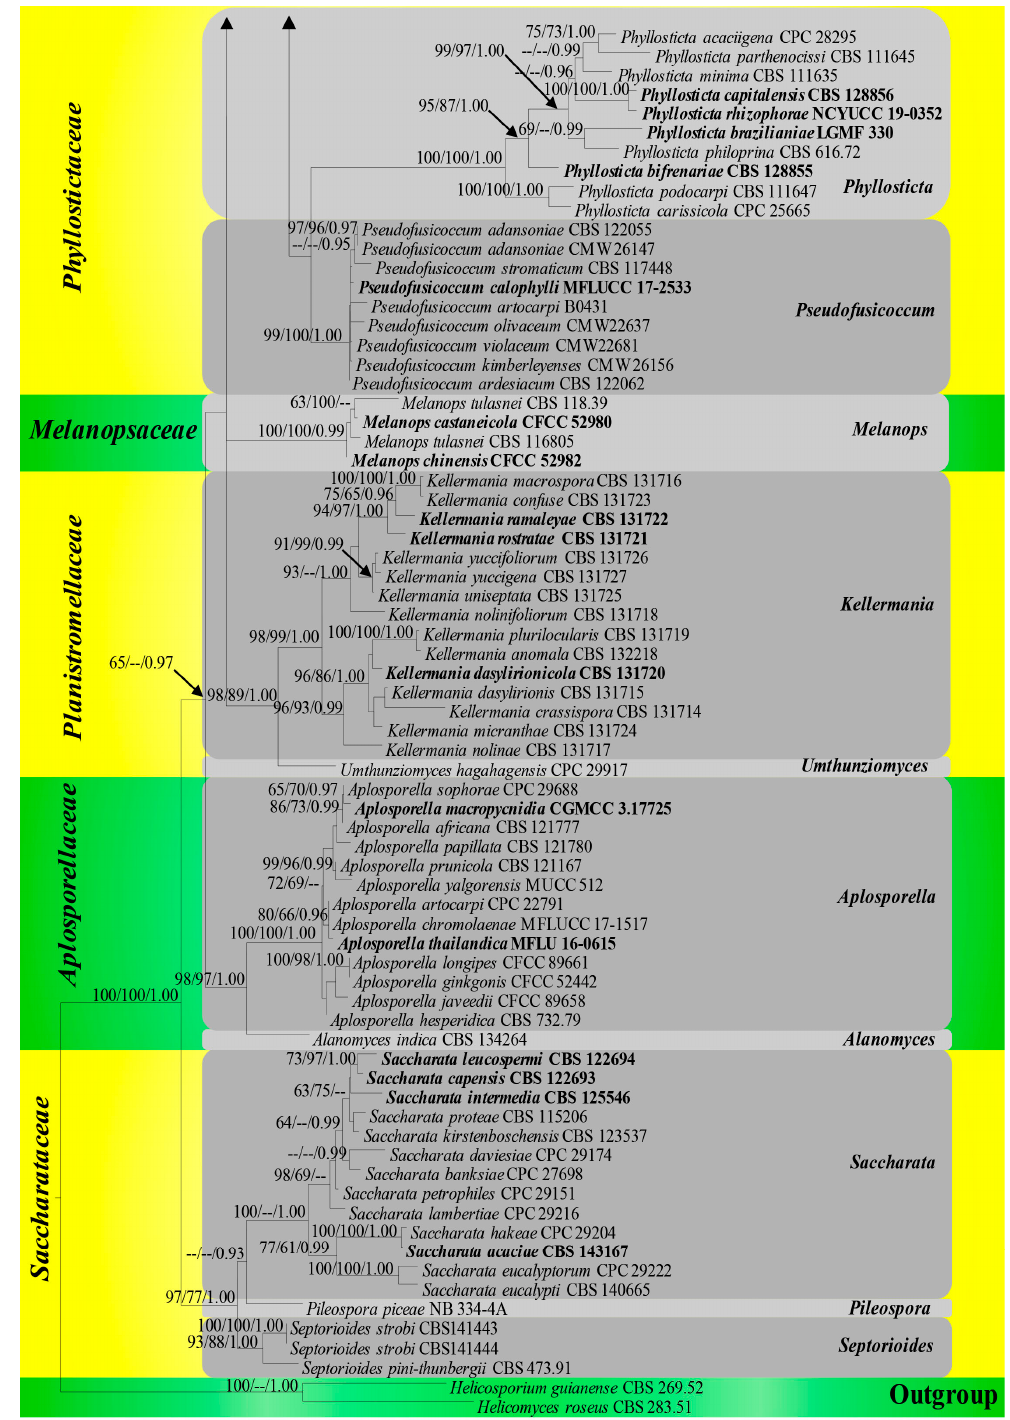
Figure 3. Phylogram generated from ML analysis based on combined LSU and ITS sequence data.